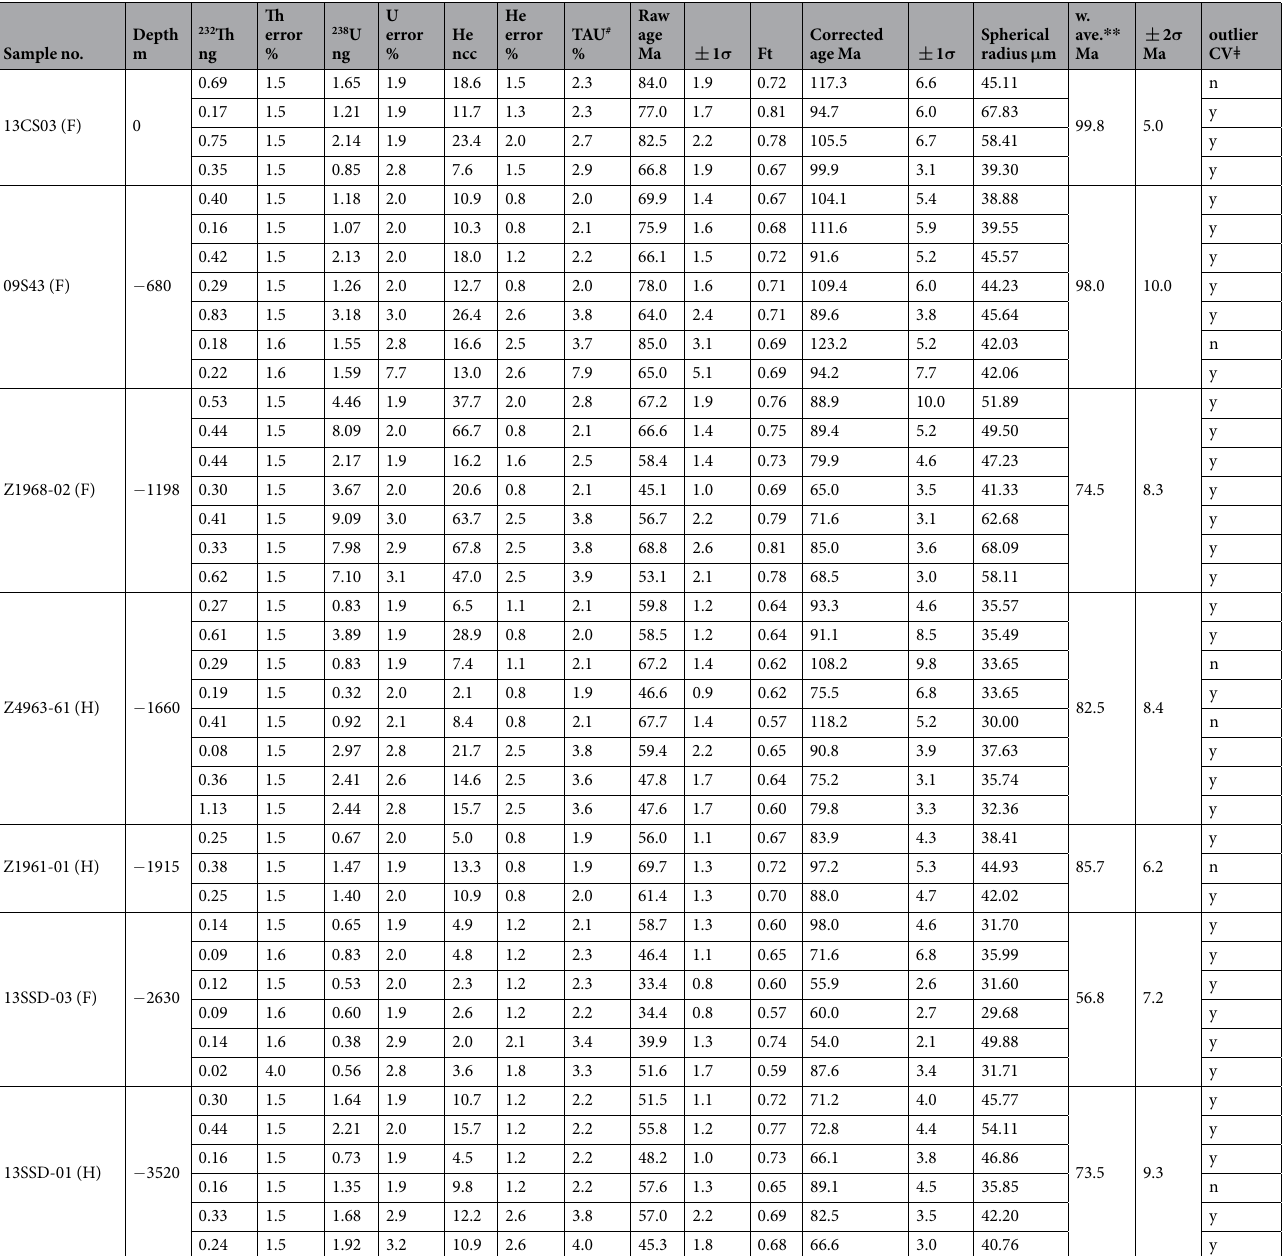
Table 3. (U-Th)/He analytical results for zircon of the Sanshandao gold deposit. Note: F and H after the sample numbers represent footwall and hanging wall. * Represents concentration of the element in femtomole (Th, U in fmol = the analyzed weight in ng/atomic (weight 232 or 238 g/mol) × 10 6 , He in fmol = the analyzed volume in ncc/molar volume for ideal gases (22.4 L/mol) × 10 3 /Ft. # Represent total analytical uncertainty. ** Represents weighted average age. ǂ Represents outlier detection by the Chauvenet’s criterion; and “n” indicates outlier and “y” indicates